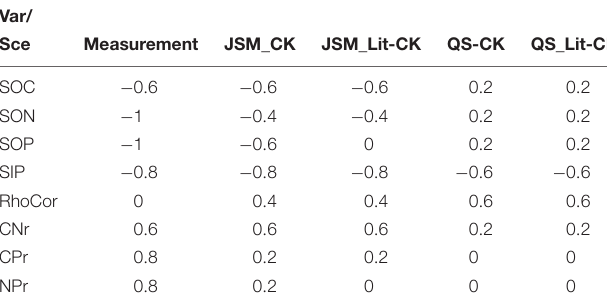
TABLE 4 | The tau ( τ ) values of the Mann–Kendall trend test for main soil variables along the soil P gradient (BBR > MTF > VES > COM > LUE) of